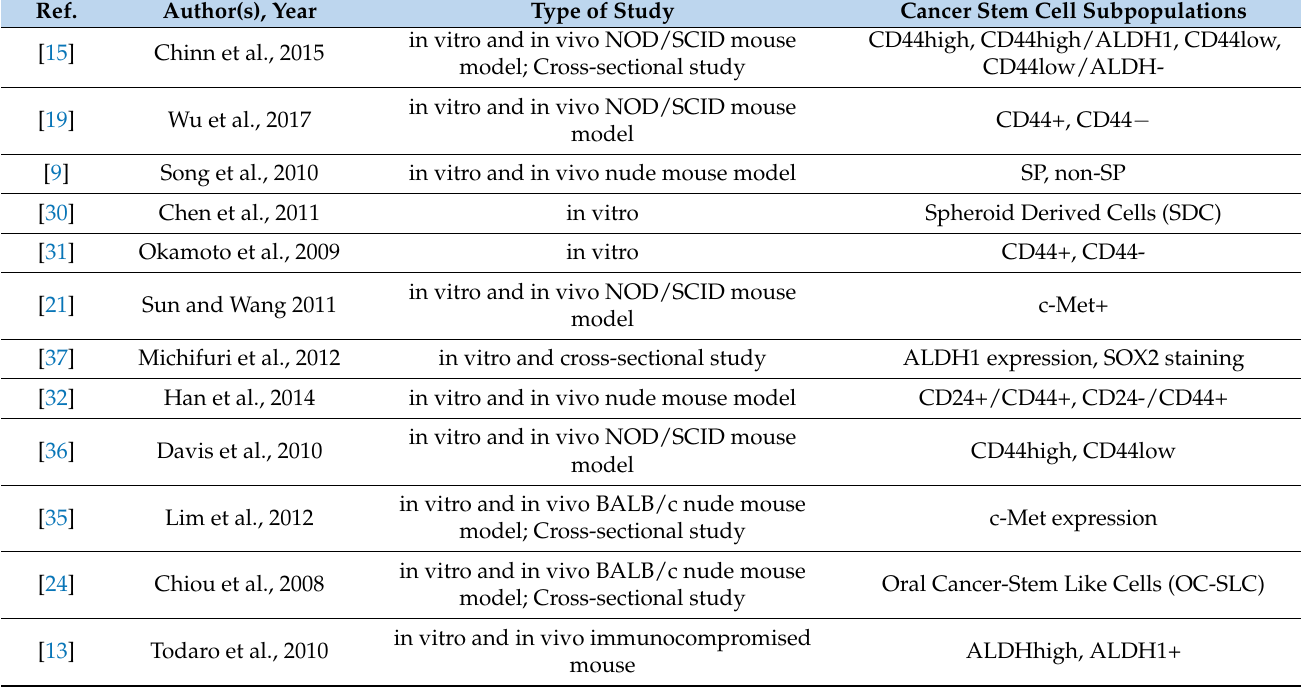
Table 2. Enhanced invasive and metastatic properties of Head and Neck Cancer Stem Cells. Experimental findings supporting a role head and neck cancer stem cells in enhancing invasive and metastatic potential.